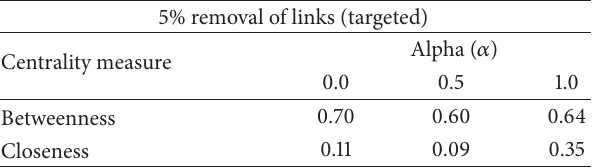
Table 4: Targeted link removal.